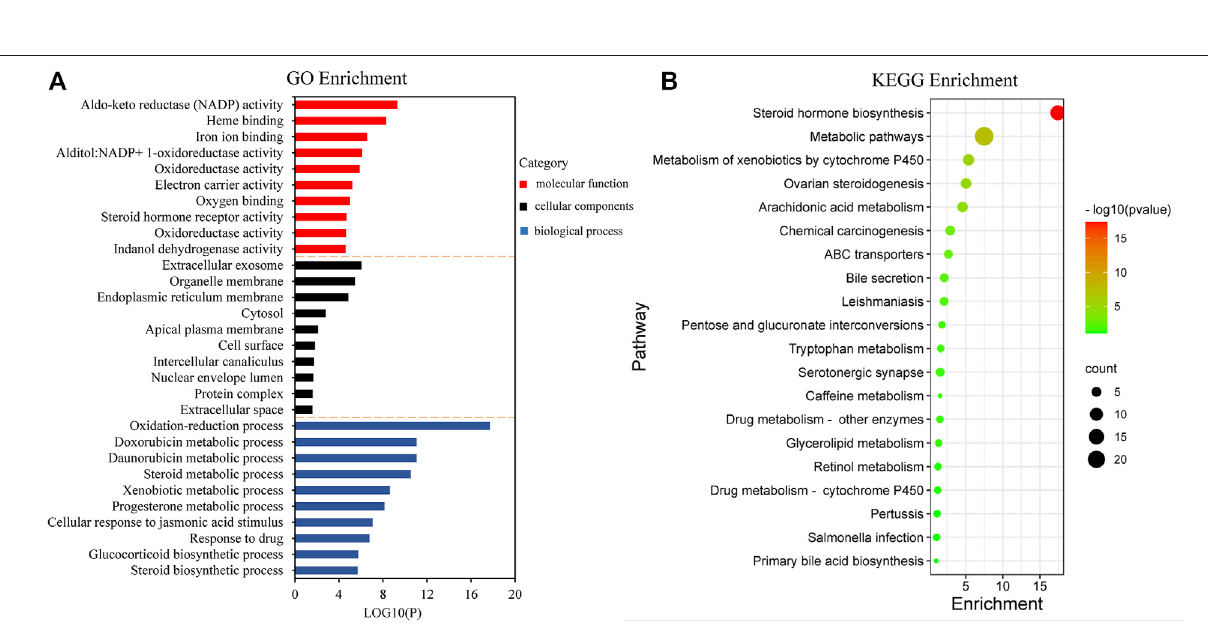
Frontiers in Pharmacology |